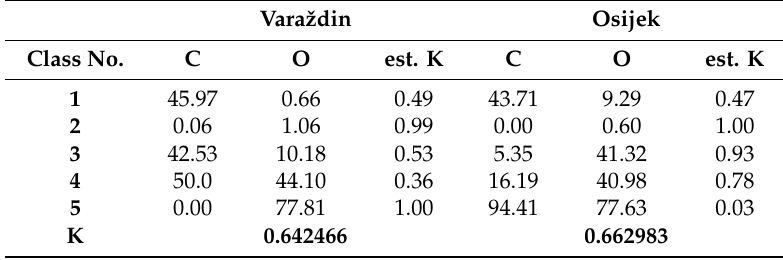
Table 10. The accuracy assessment of the naïve Bayes algorithm for Varaždin (left) and for Osijek (right). Varaždin Osijek Class No.